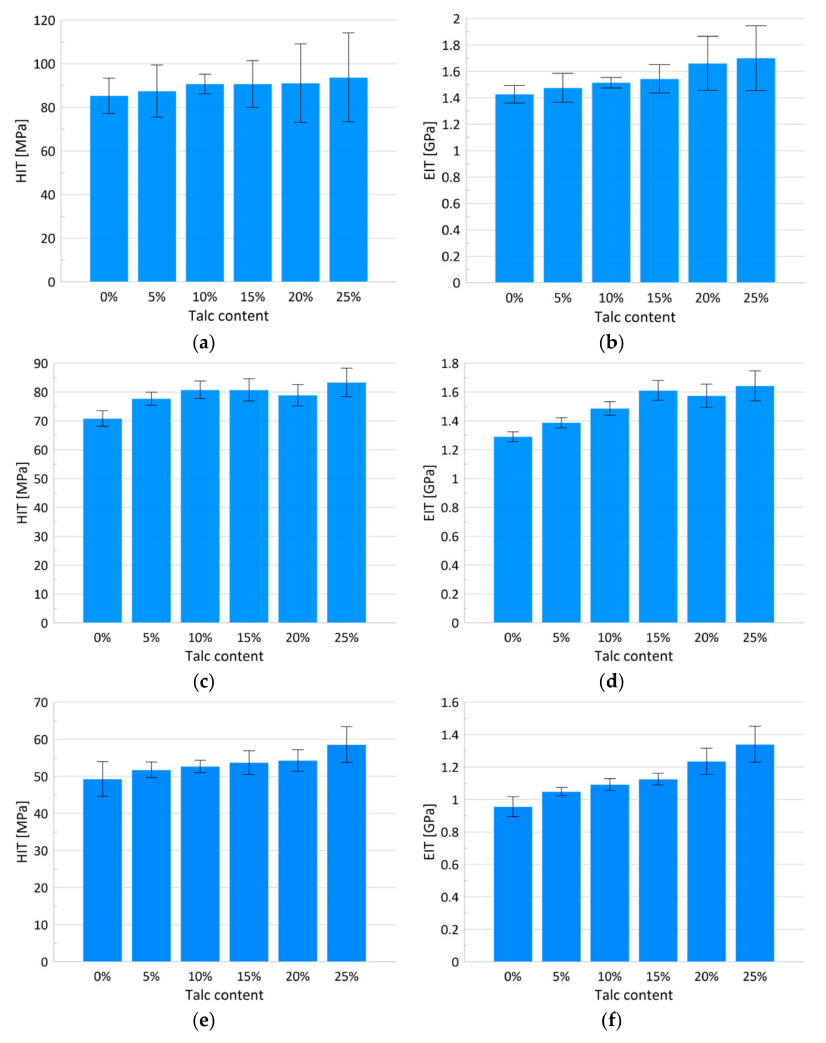
Figure 5. Bar charts of the hardness with corresponding standard deviations for penetration depth of 300, 800 and 4000 nm, respectively ( a , c , e ); bar charts of the modulus of elasticity with corresponding standard deviations for penetration depth of 300, 800 and 4000 nm, respectively ( b , d , f